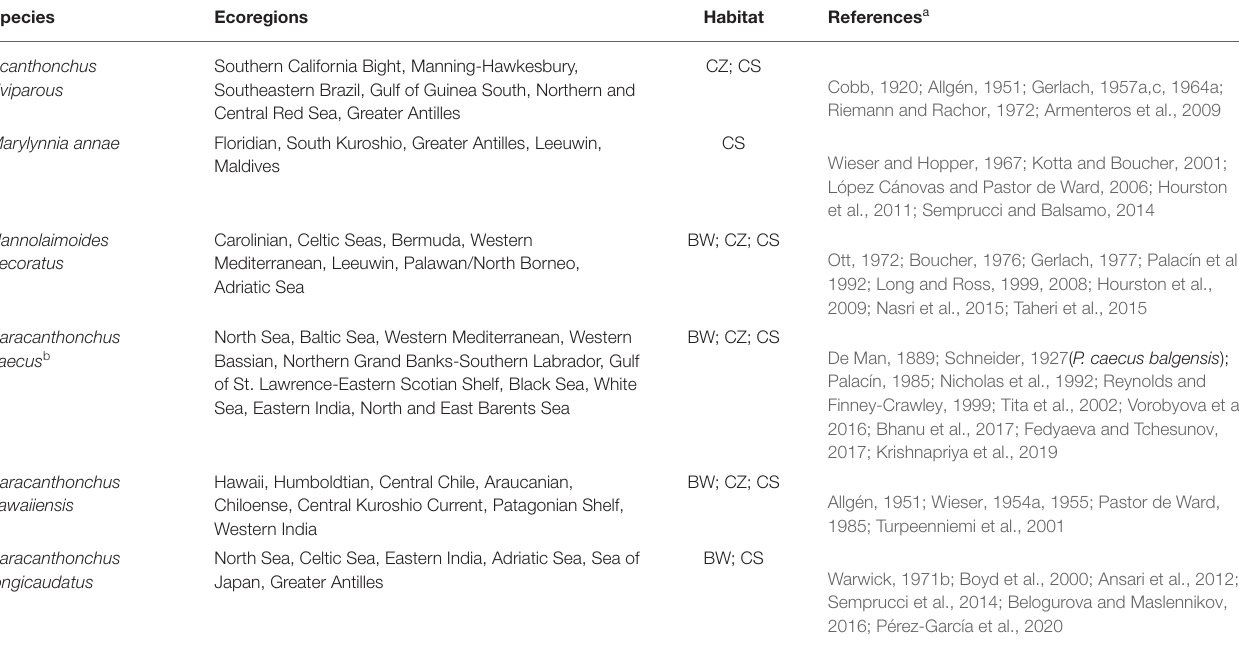
TABLE 2 | Cyatholaimidae species most broadly distributed, recorded in more than five ecoregions nested in at least four different realms. Species Ecoregions